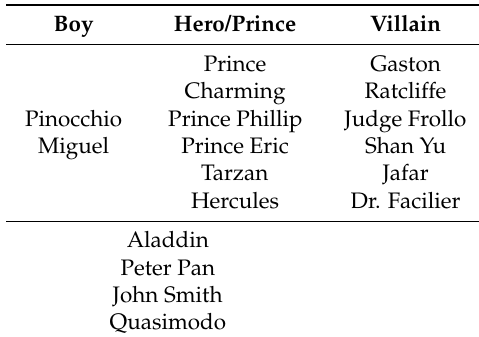
Table 1. Models of Disney